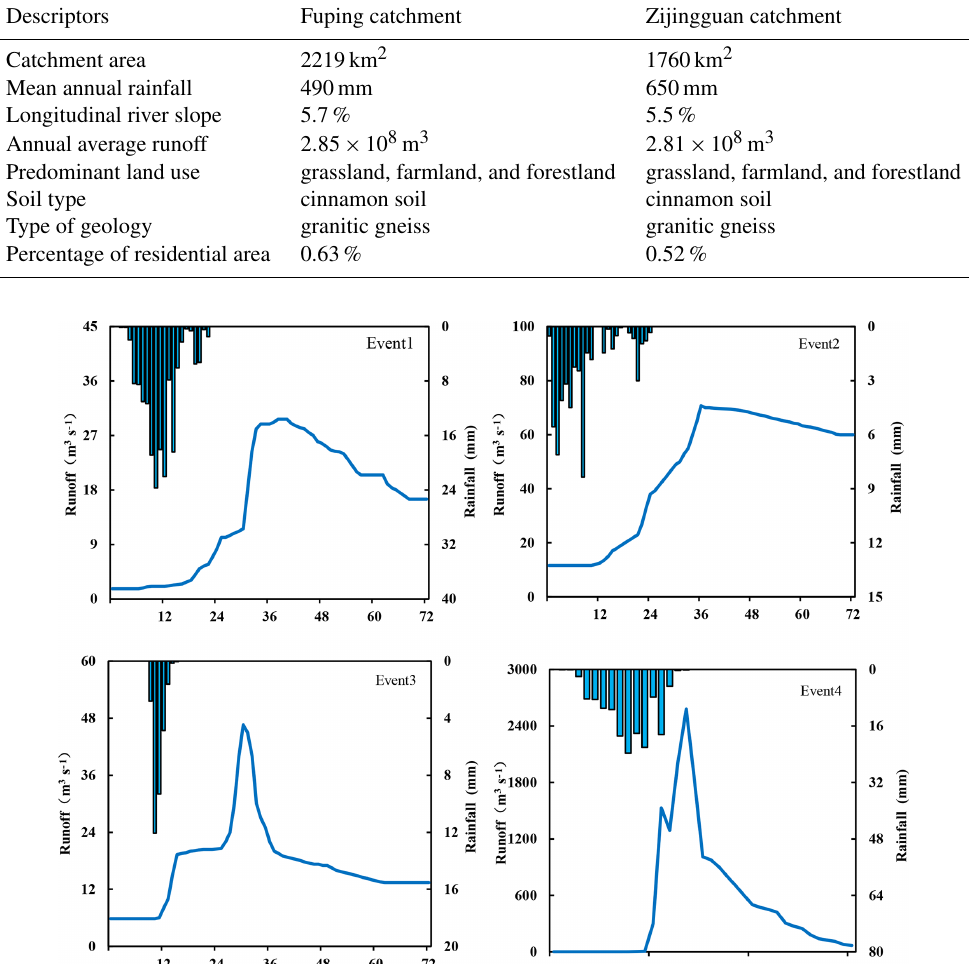
Figure 4. Rainfall–runoff processes of the four 24h storm